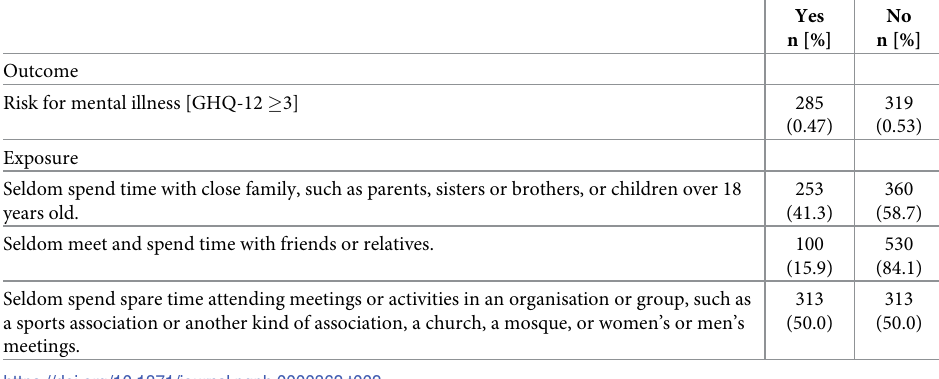
Table 2. Frequencies and percentages for the outcome and exposure variables.